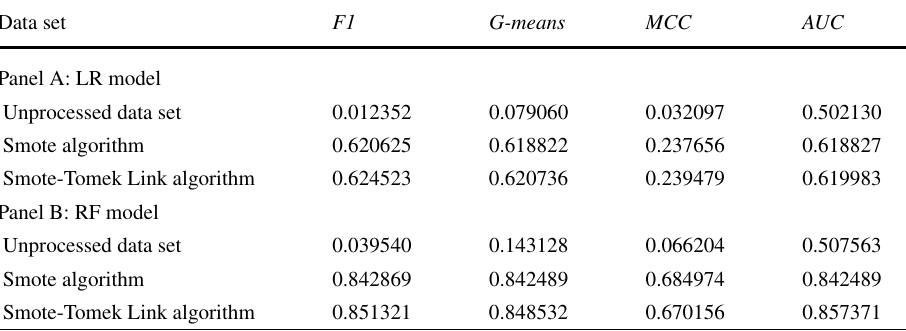
Table 6 Classification results based on LR and RF